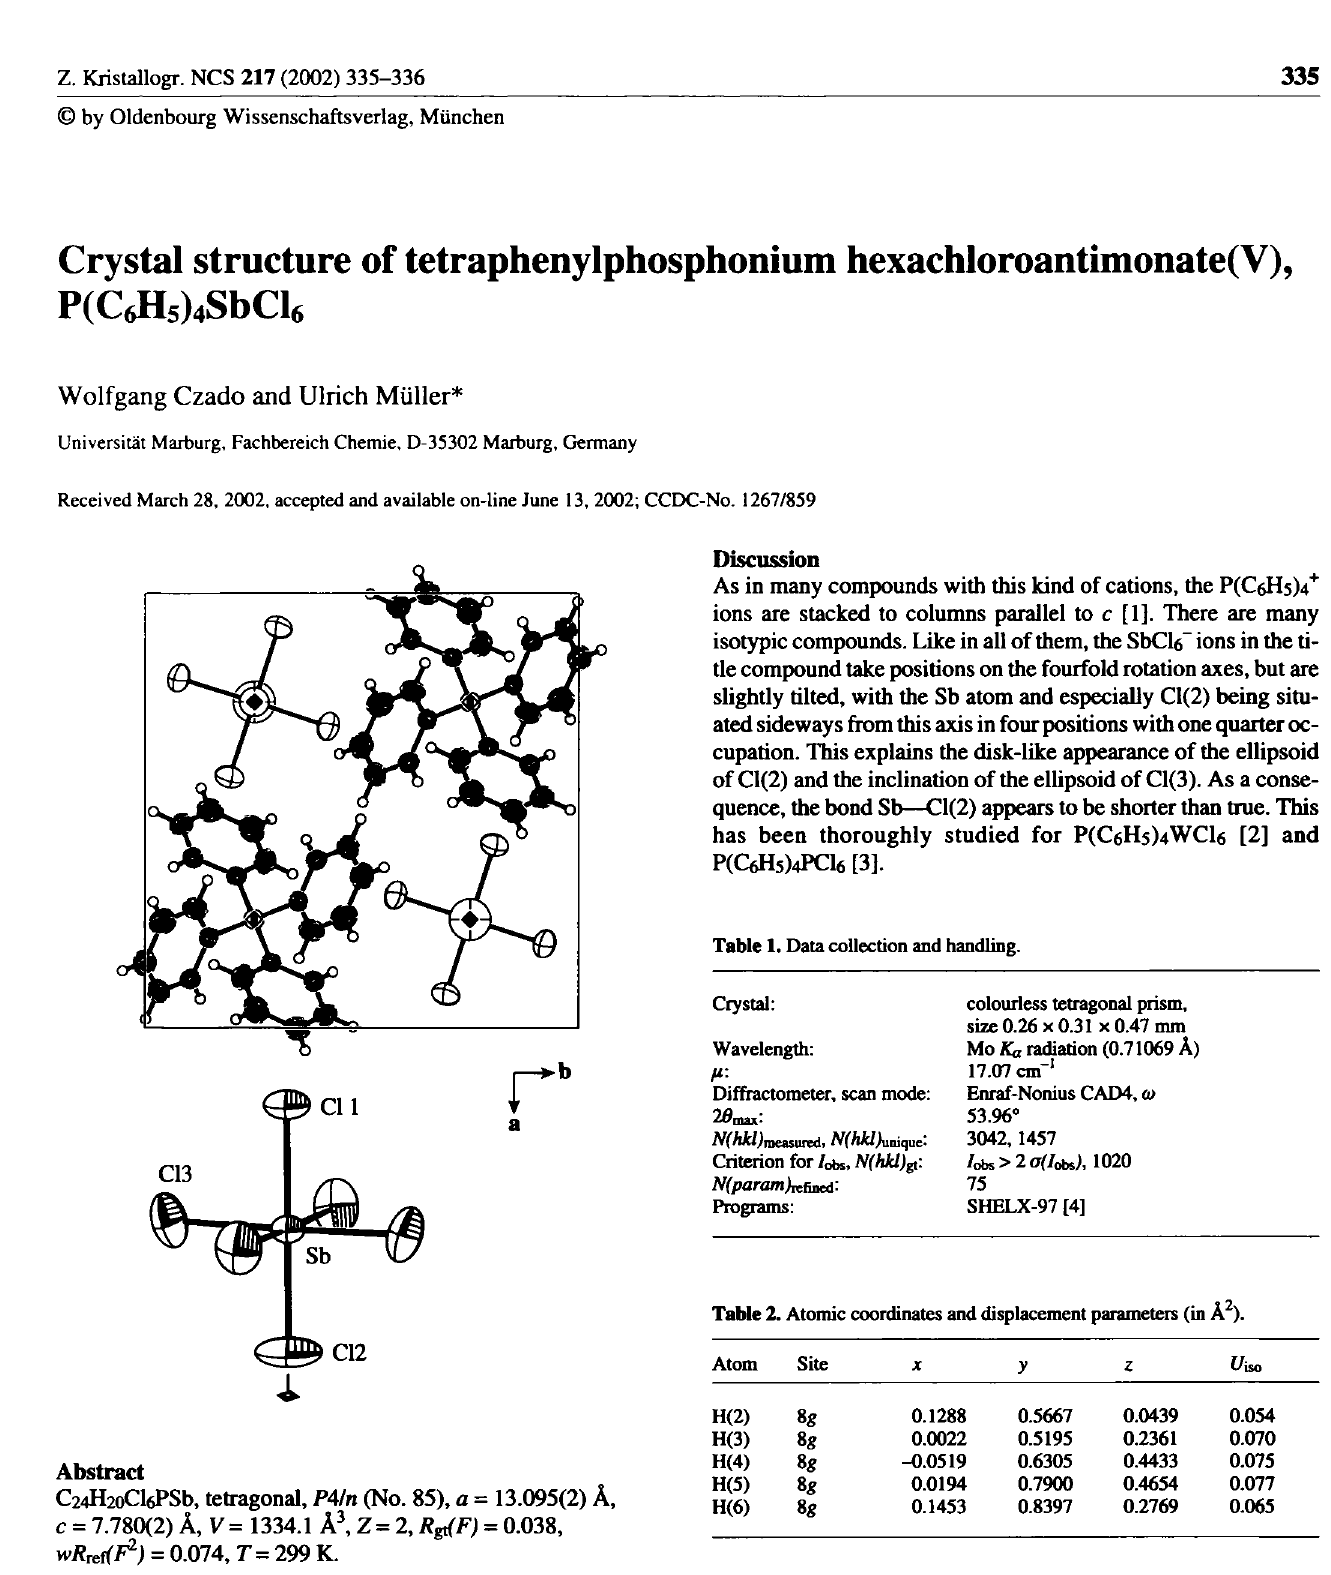
Table 2. Atomic coordinates and displacement parameters (in Â 2